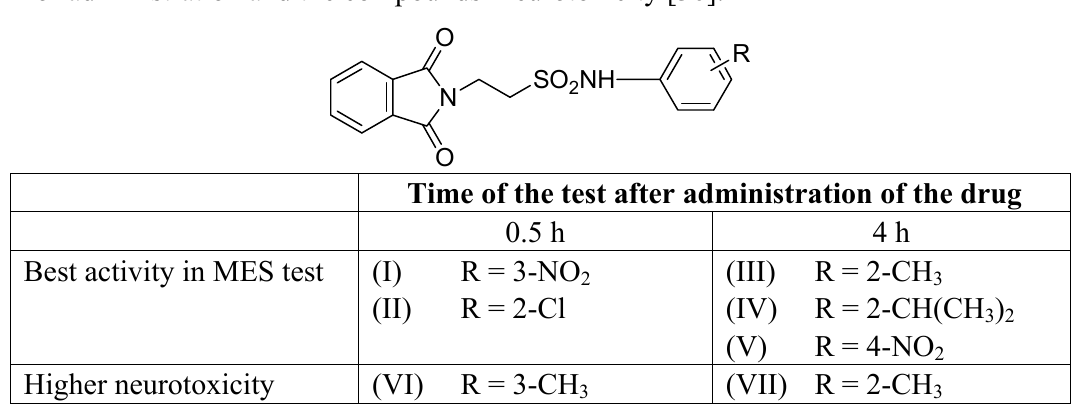
Table1. Best phenyl phtalimidoethanesulfonamide derivatives in MES test after 0.5 and 4 h of administration and the compounds’ neurotoxicity